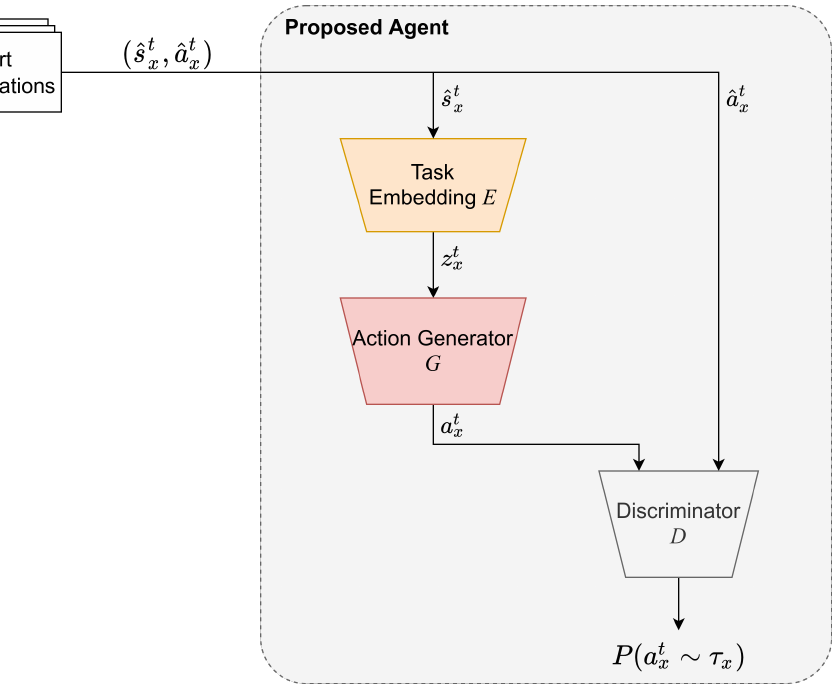
Figure 2. The neural network architecture of the proposed